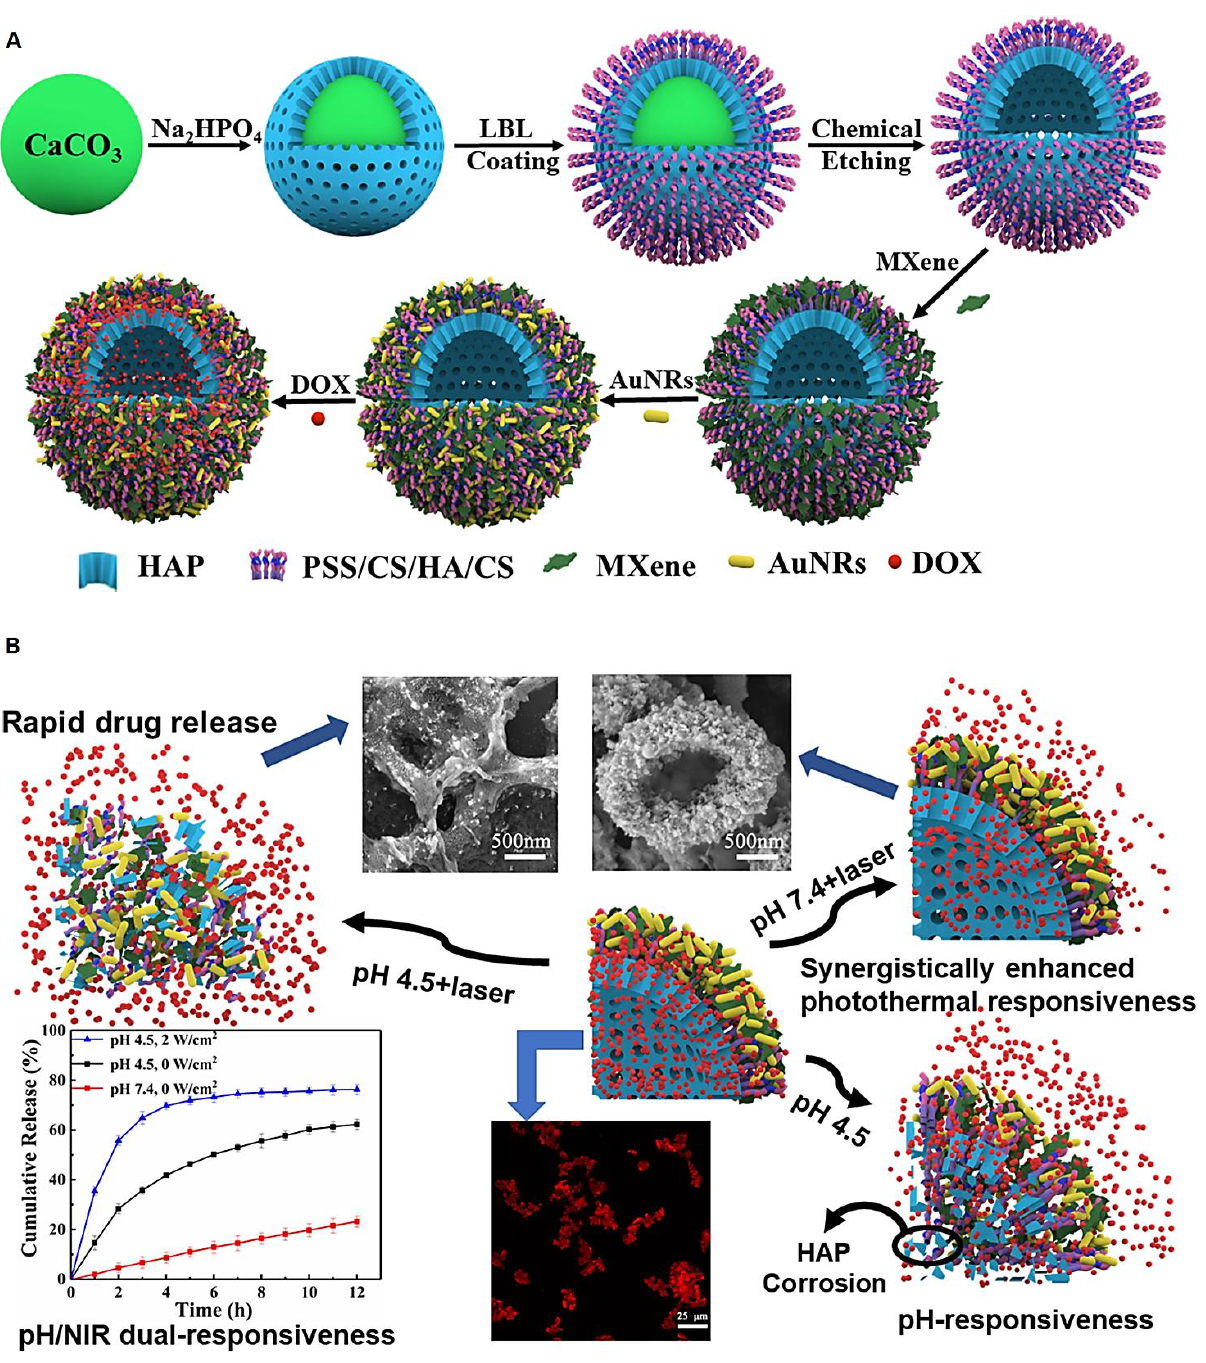
Figure 3. ( A ) The preparative process of drug delivery microcapsules that were constructed from hollow hydroxyapatite (HAP), chitosan (CS), hyaluronic acid (HA), gold nanorods (Au NRs), and MXene. ( B ) These microcapsules with pH-/NIR-responsive drug release behavior were deployed for the targeted delivery of doxorubicin (DOX). Adapted from Ref. [54] with permission. Copyright 2021 Elsevier.